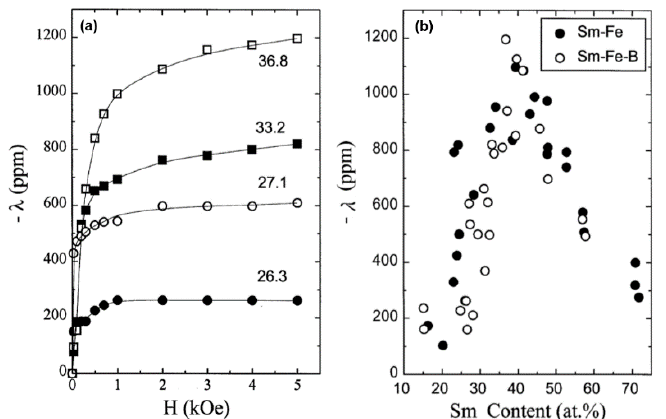
Figure 10. ( a ) The λ-H plots for some Sm-Fe-B thin films. The numbers at the curves indicate the Sm content in at% ( b ) The value of λ as a function of the Sm content at fixed magnetic fields of 5 kOe. The results of Sm-Fe thin films are indicated by filled circles while those of Sm-Fe-B thin films are denoted by open circles. Reprinted with permission from [102]. Copyright [1998], North Holland (Elsevier).